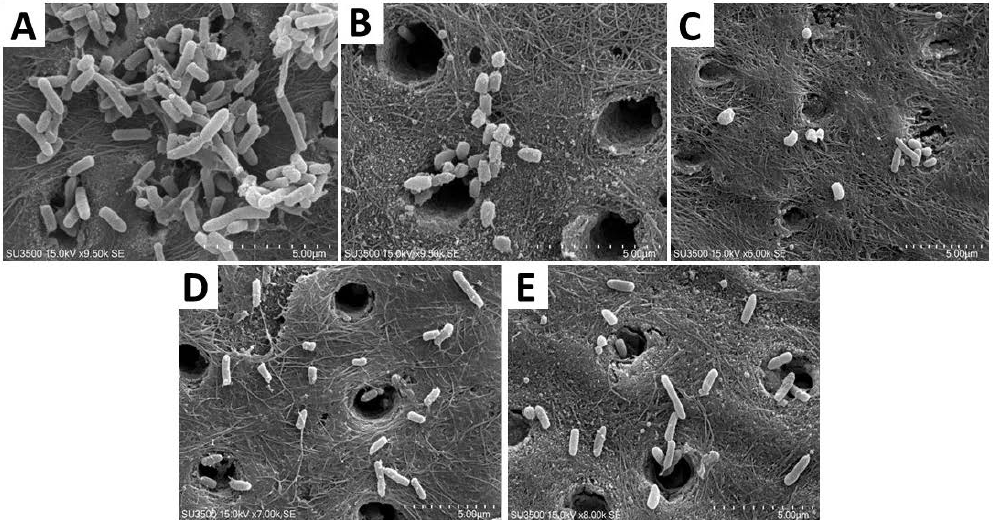
Figure 3. SEM images of P. gingivalis biofilm-dentin specimens (on day 7) after the application of different concentrations of ε -polylysine (5 µm). ( A ) control; ( B ) 0.125% ε -PL; ( C ) 0.25% ε -PL; ( D ) 0.5% ε -PL; ( E ) 1% ε -PL P. gingivalis bacterial cells are reduced in number and display an irregular cell morphology because of membrane disruption.